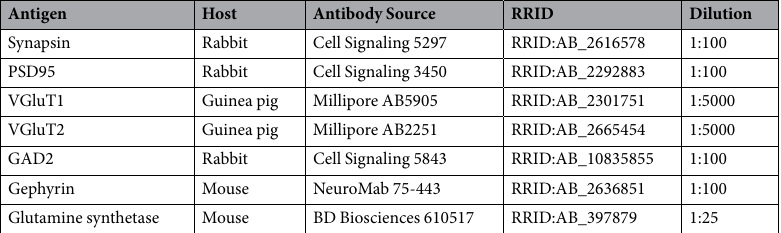
Table 1. Antibodies used for the